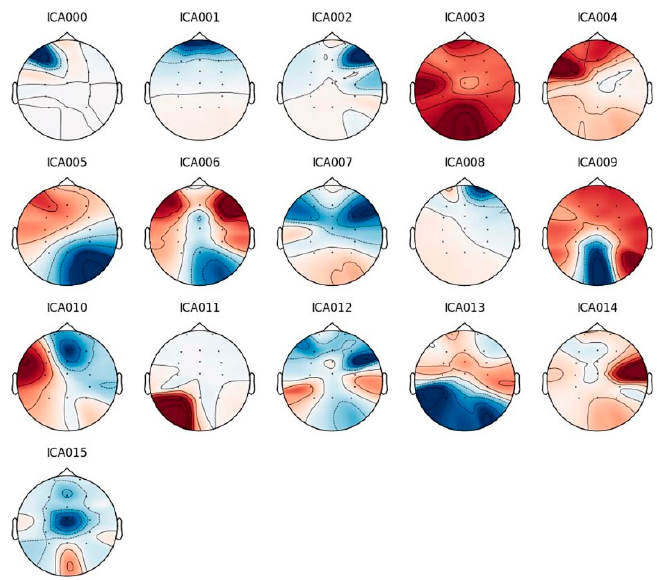
Figure 1. Topographic map of ICA components.